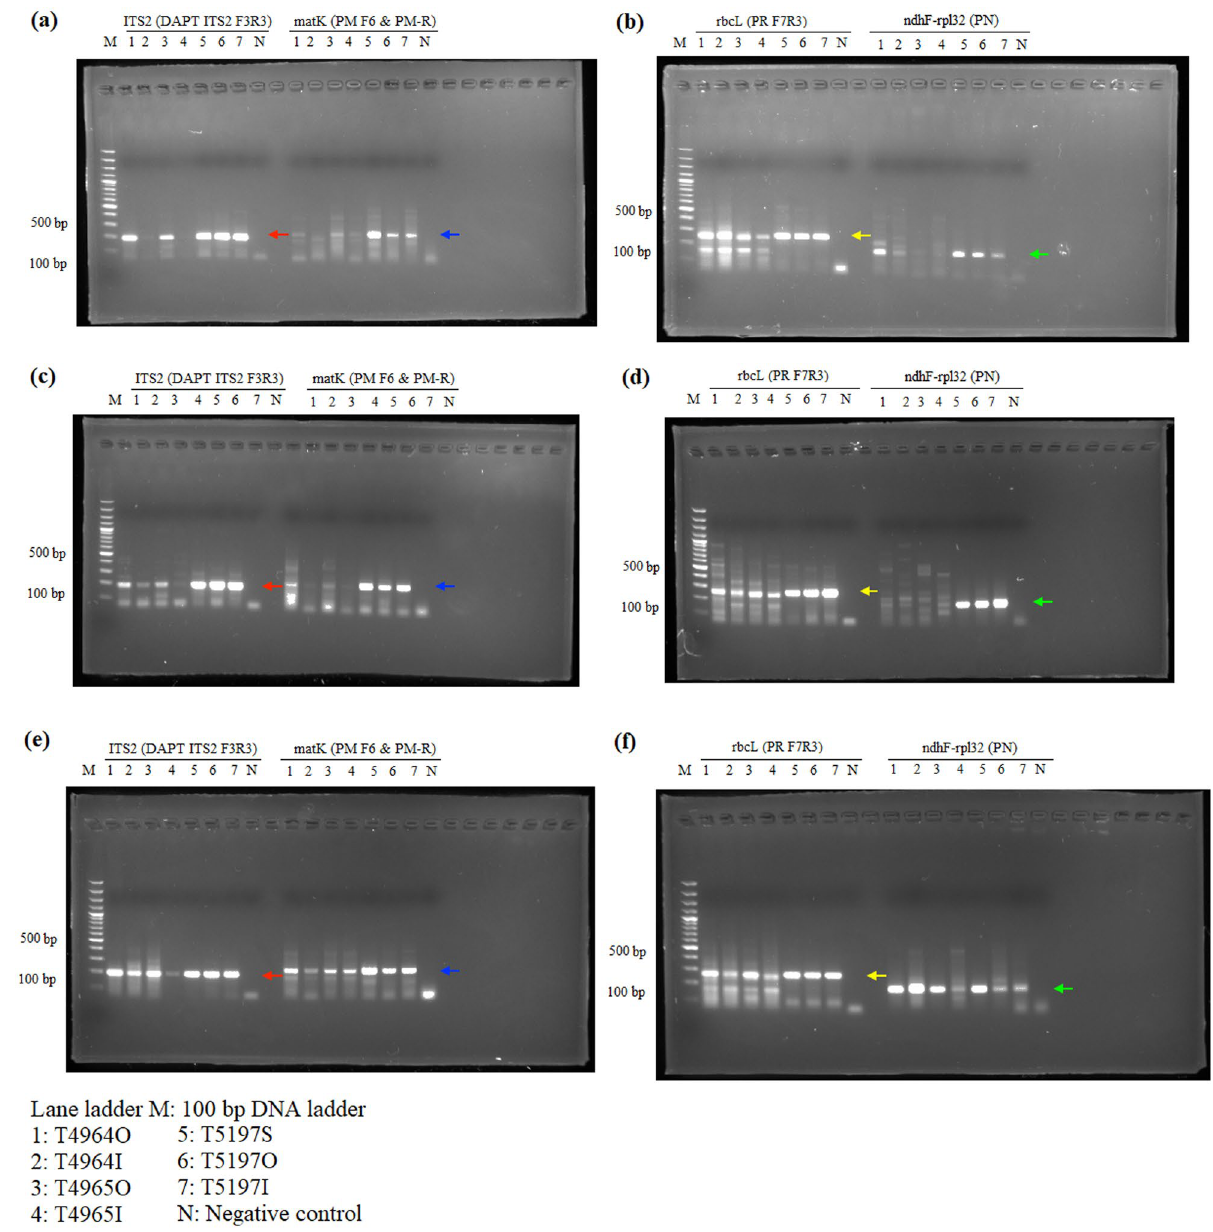
Figure 4. Gel electrophoresis of PCR amplification results of Pterocarpus authentic wood samples using different extraction methods, ( a , b ) SDS-based method, ( c , d ) QIAGEN method, and ( e , f ) CCDB method. Red arrows indicate the amplicons of ITS2 (180 bp). Blue arrows indicate the amplicons of matK (200 bp). Yellow arrows indicate the amplicons of rbcL (250 bp). Green arrows indicate the amplicons of ndhF-rpl32 (167– 173